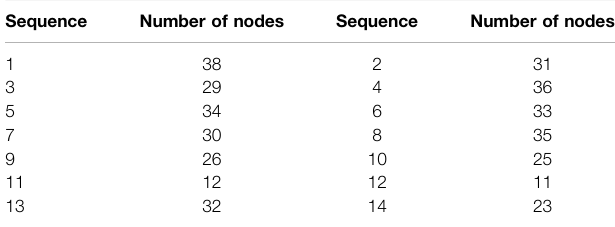
TABLE 6 | The node ’ s importance sorting table.